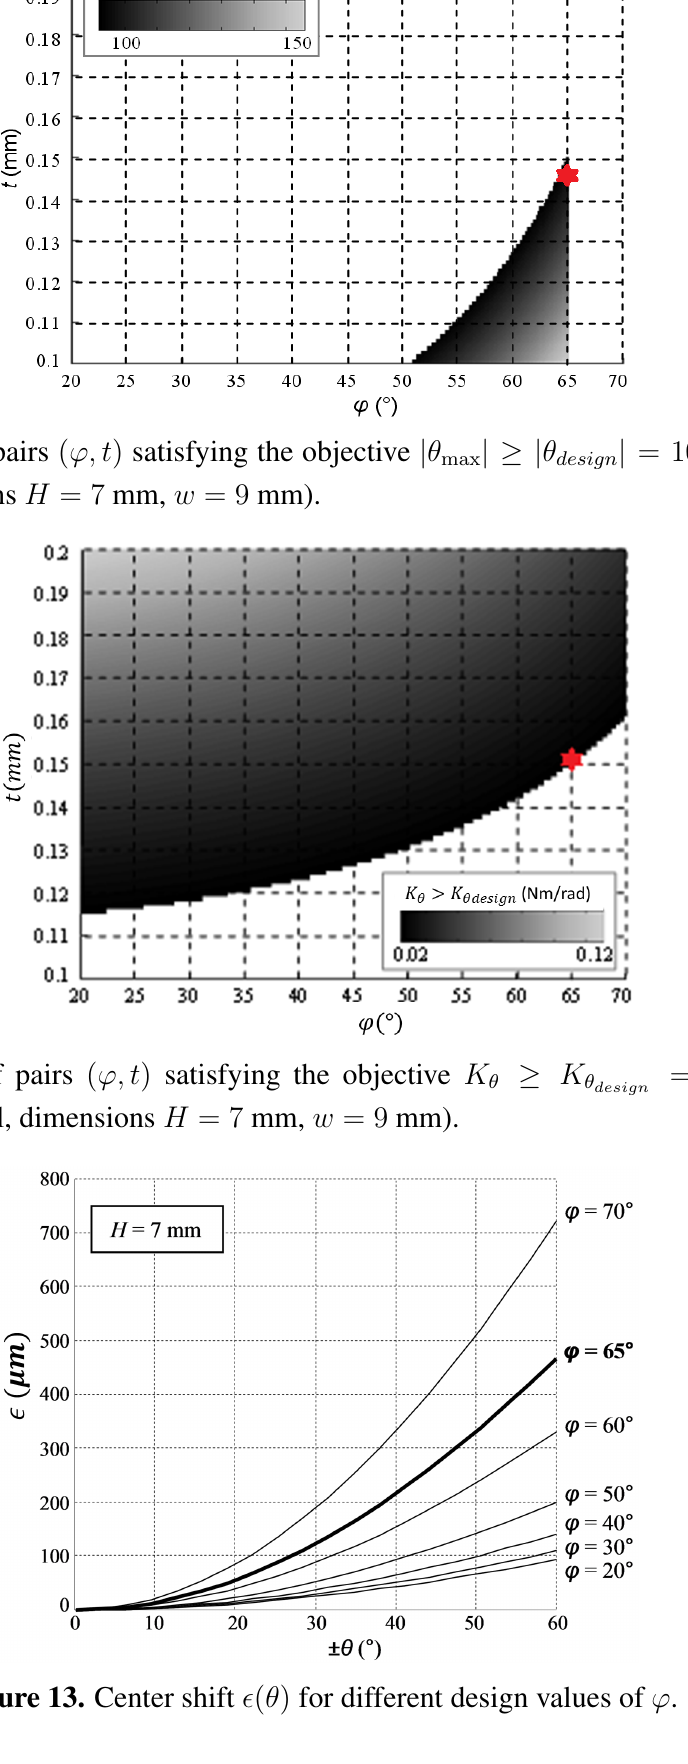
Figure 13. Center shift (cid:15) ( θ ) for different design values of ϕ